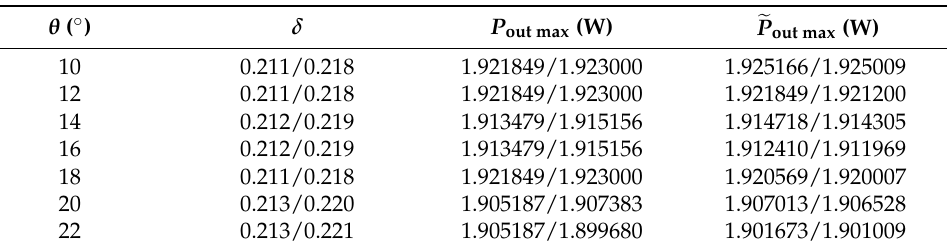
Table 1. Optimal value of δ under different angles of θ. ( T a = T H / T a = T C ). θ ( ◦ )